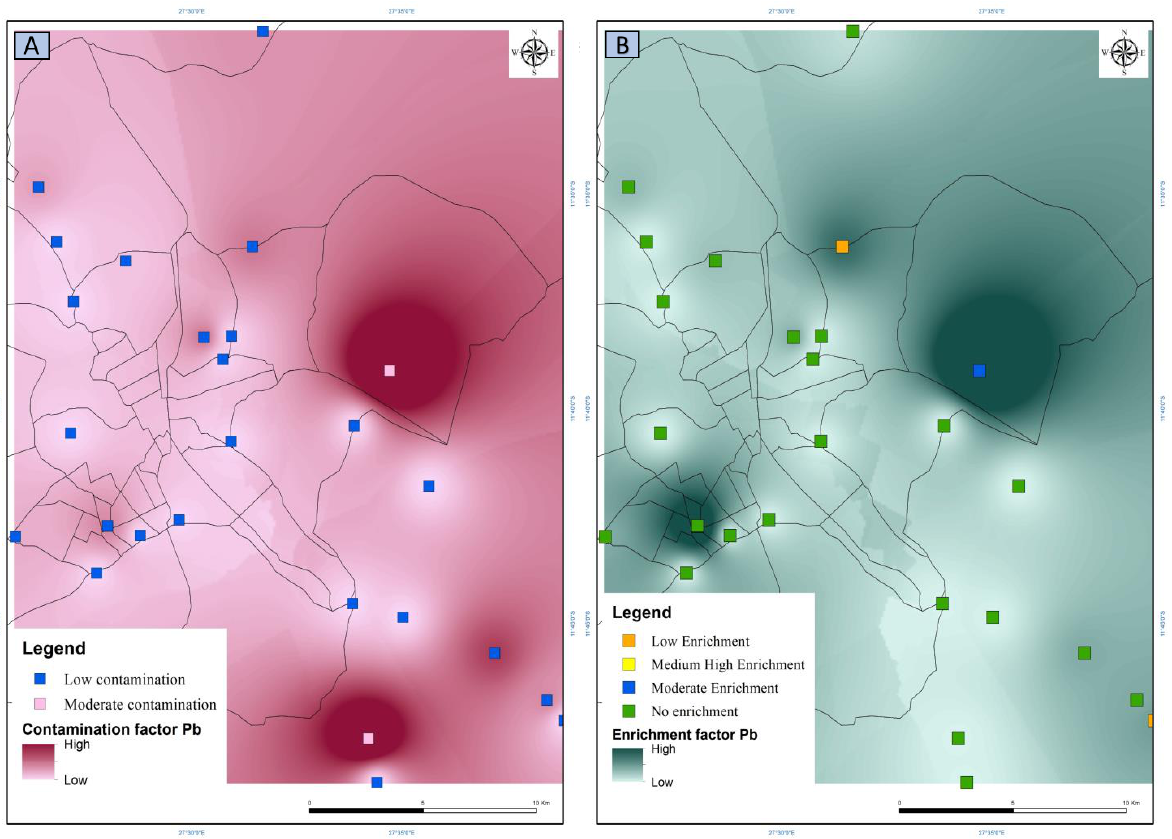
Figure 5. Spatial distribution of metals (Cu) in the market garden soils according to their contami- nation factor (A) and enrichment factor (B).